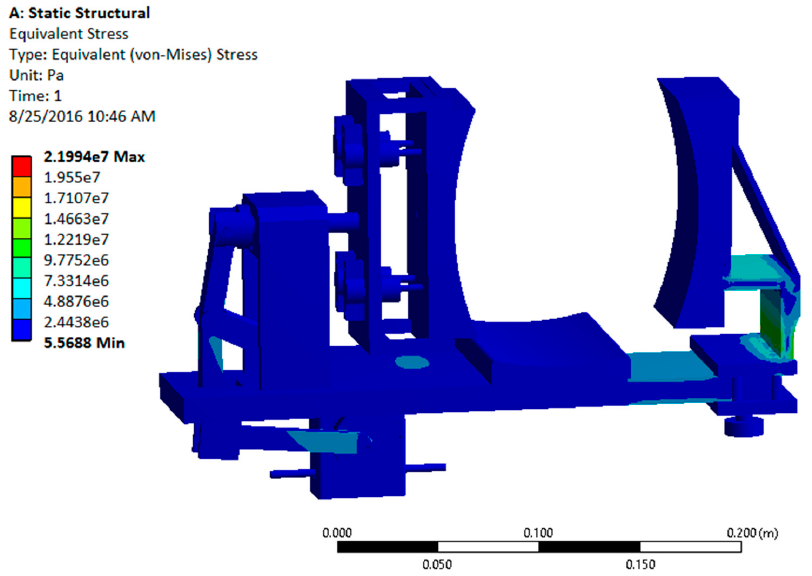
Figure 10. von Mises (equivalent) stress contour plot for metal and Acrylonitrile Butadiene Styrene (ABS) plastic configuration.